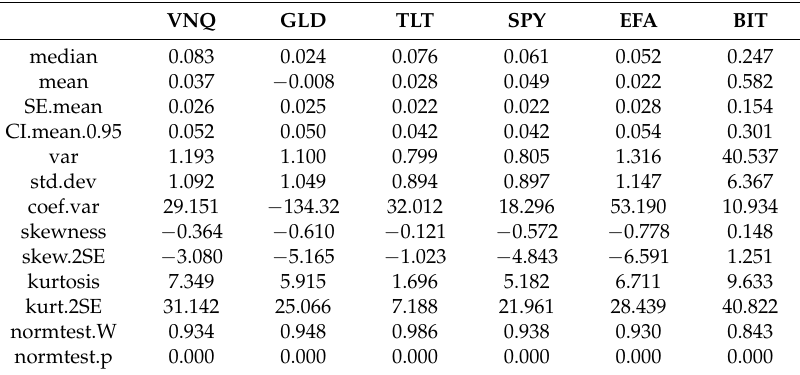
Table 1. Summary statistics for daily percent returns.